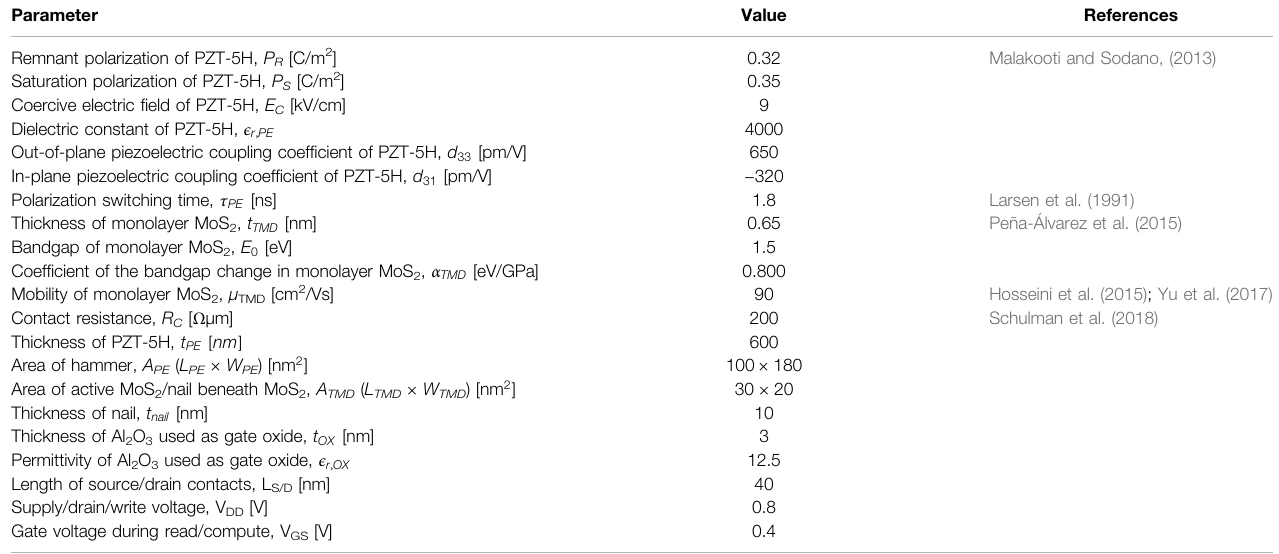
TABLE 1 | Parameters used in the PeFET